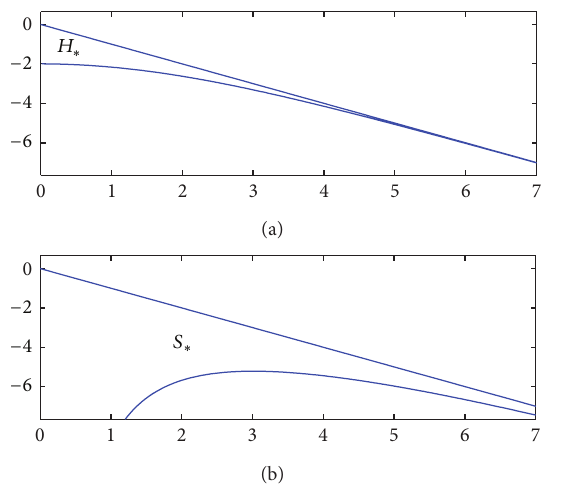
Figure 4: The analytic solution and the numerical solution of (39) with 𝑛 = 2 and 𝑚 = 40 .